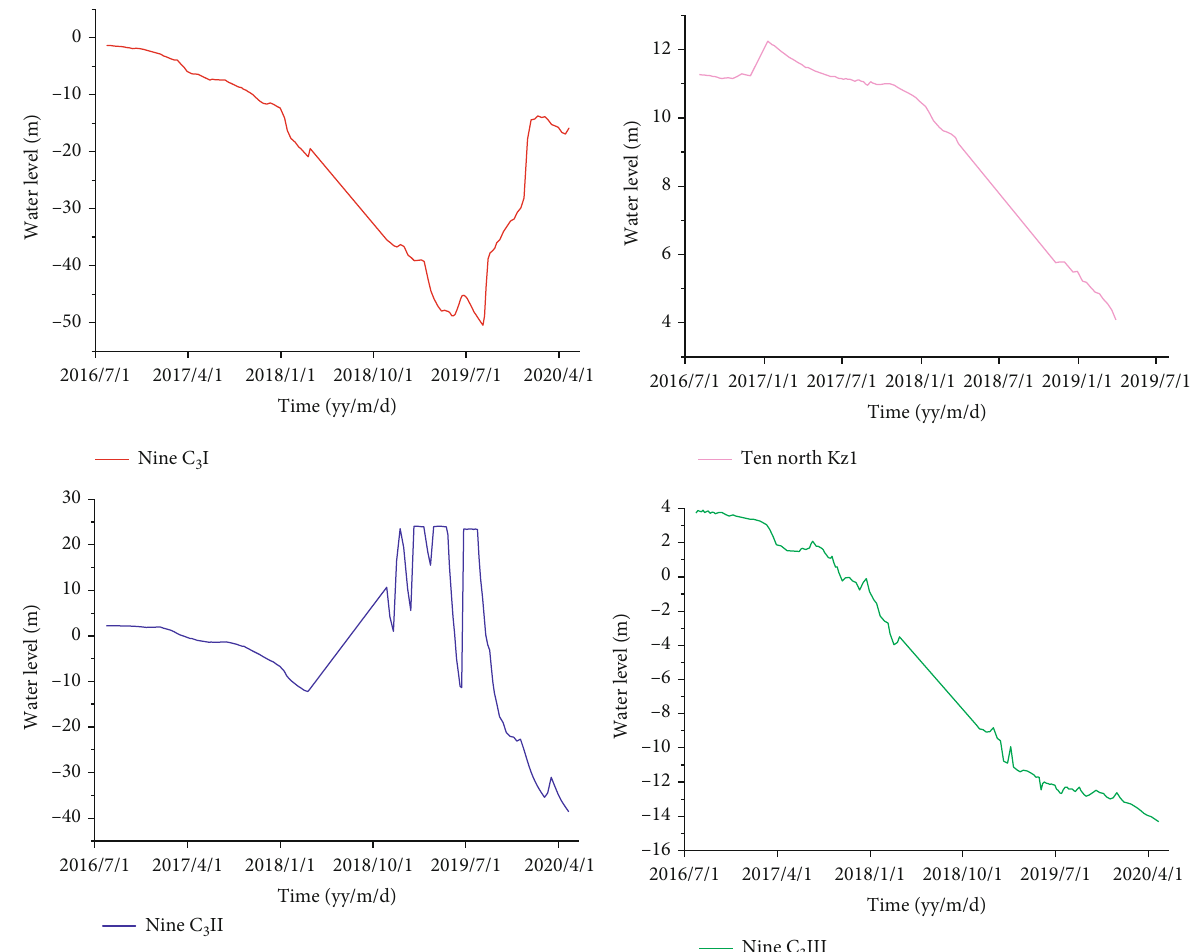
Figure 9: Hydrogeological observation well dynamic curves of Carboniferous limestone aquifers (C mining area after water damage prevention and